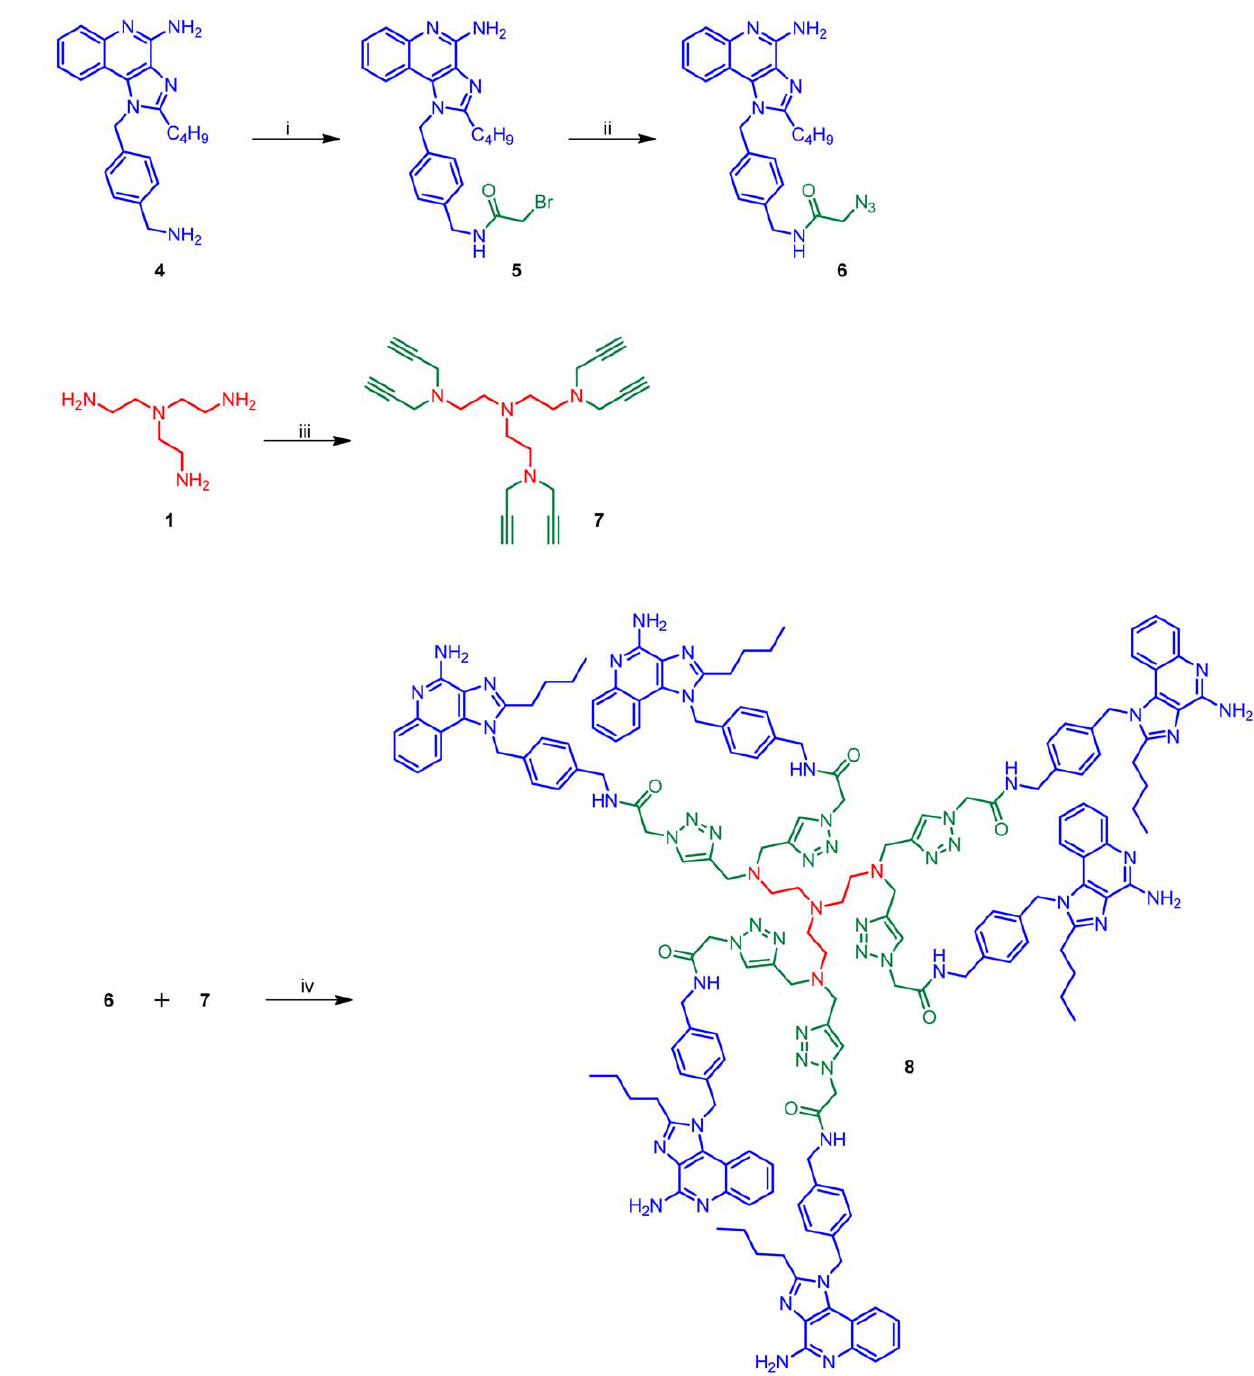
Figure 2. Synthesis of Click reaction derived imidazoquinoline dendrimer 8. doi:10.1371/journal.pone.0043612.g002 Synthesis of Compound 7: N 1 , N 1 -bis(2-(di(prop-2-yn-1-